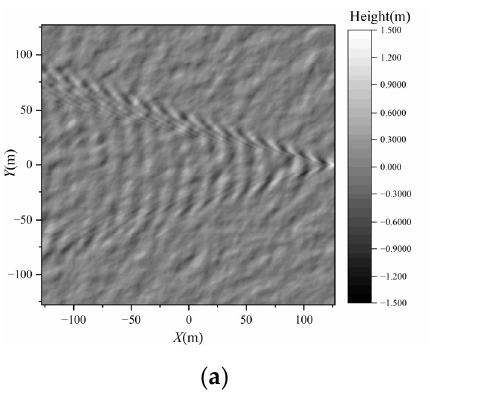
Figure 6. Simulation flow chart of ship wake SAR image in sea background.